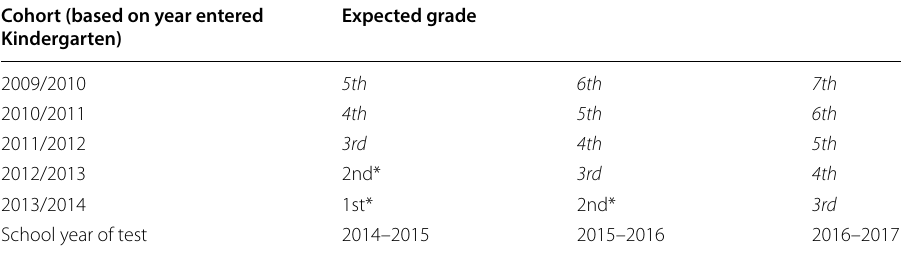
*Standardized testing not required until 3rd grade. ACT Aspire results are only available for 3rd through 7th grades, beginning with the 2014–2015 school year Italic cells show data included in analyses